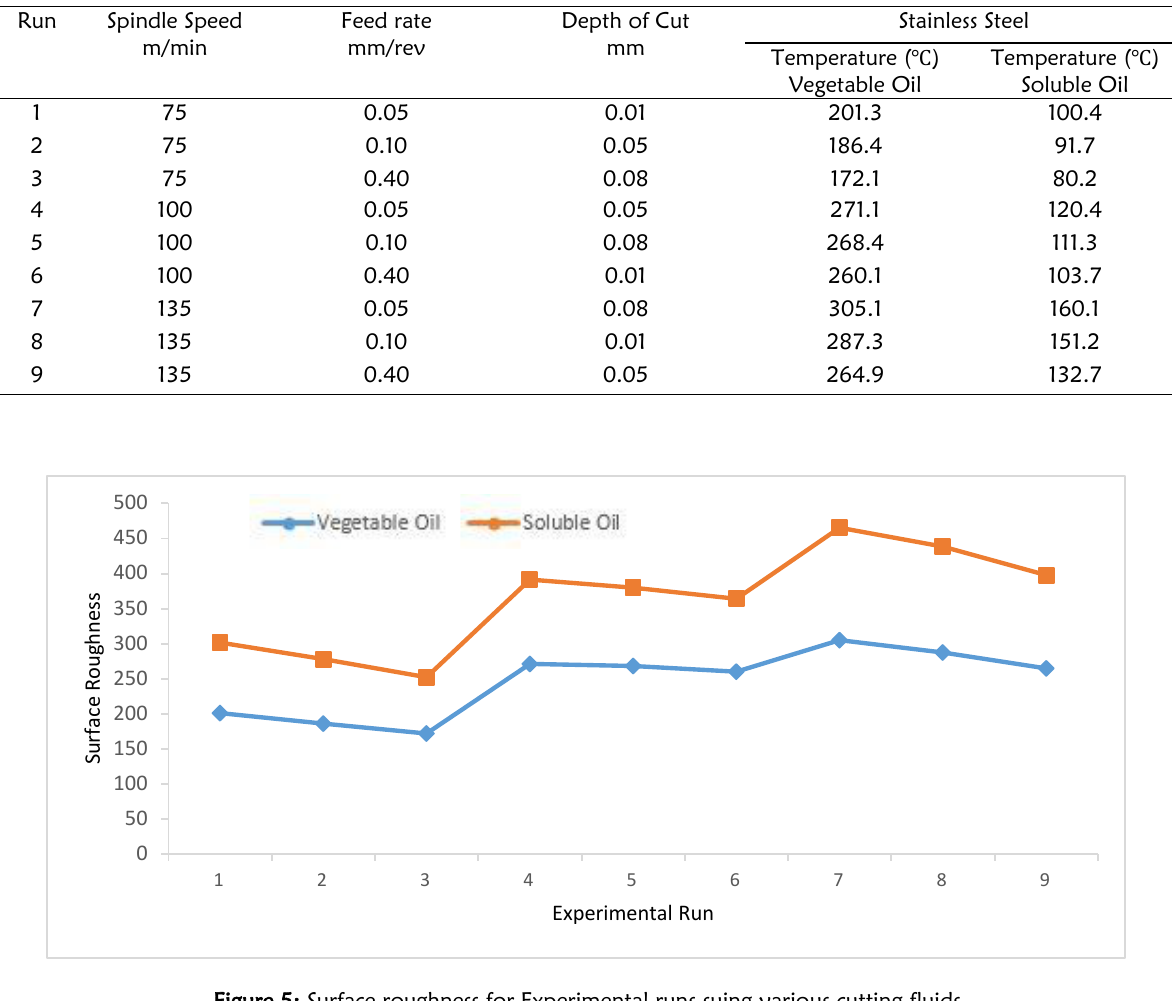
Figure 5: Surface roughness for Experimental runs suing various cutting fluids